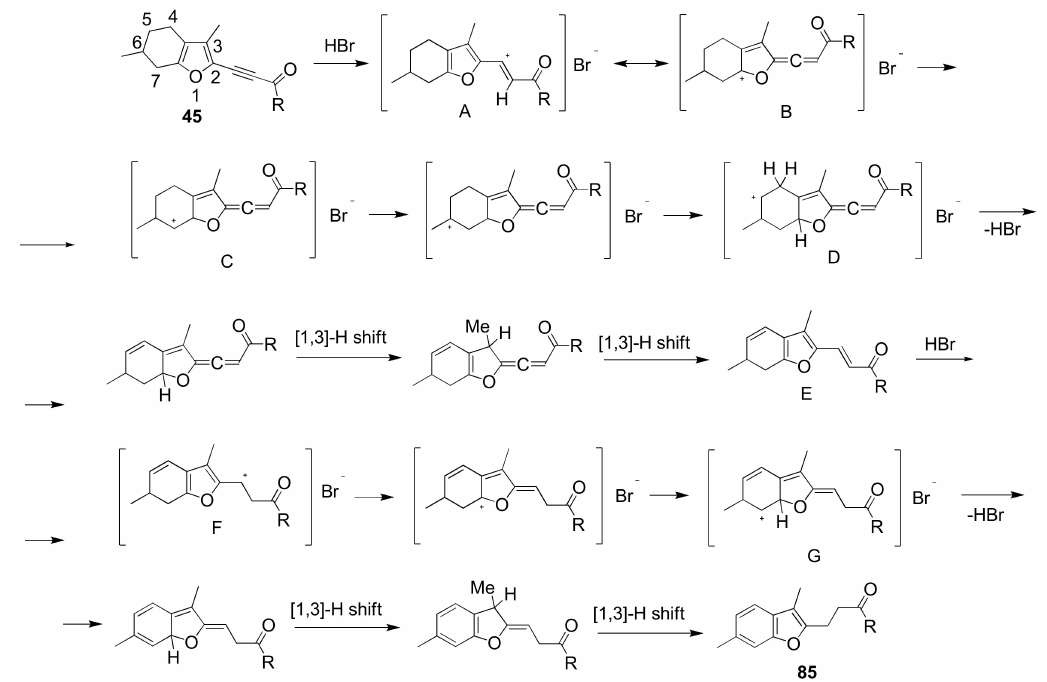
Scheme 49. Proposed mechanism for the transfer of four